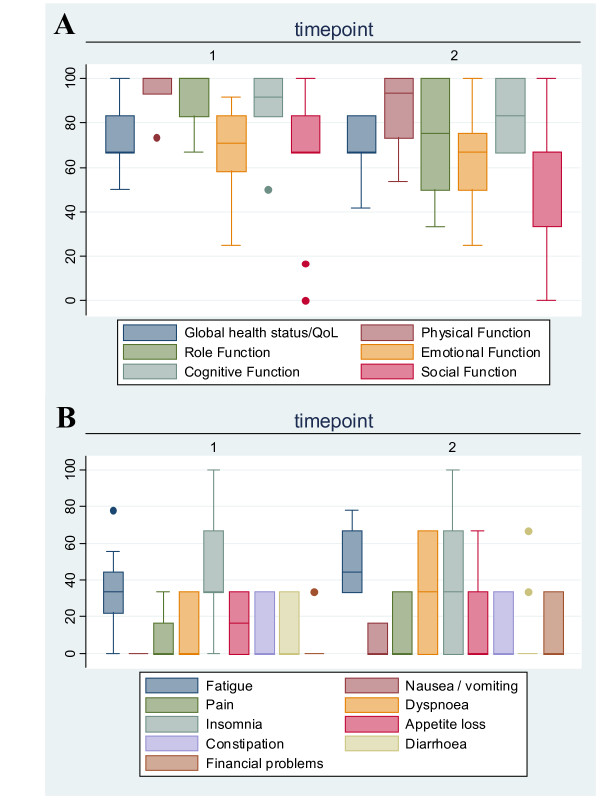
QLQ-C30 Scores. To address quality of life during chemotherapy, the QLQ-C30 questionnaire was used [17]. The scores were calculated according to the manual. The questionnaire was filled after the first cycle (timepoint 1) and after the last cycle (timepoint 2), 10 patients were eligible completing 4 (n = 9) or 6 (n = 1) cycles. (A) Functional scores (high score corresponds to high functionality) (B) Symptom scores (low score correspond to mild symptoms).